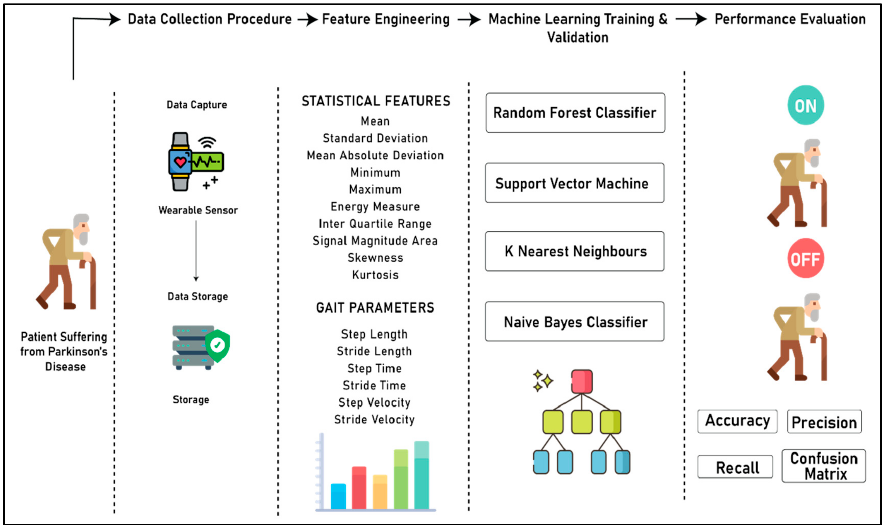
Figure 3. Complete process flow of the experiment.